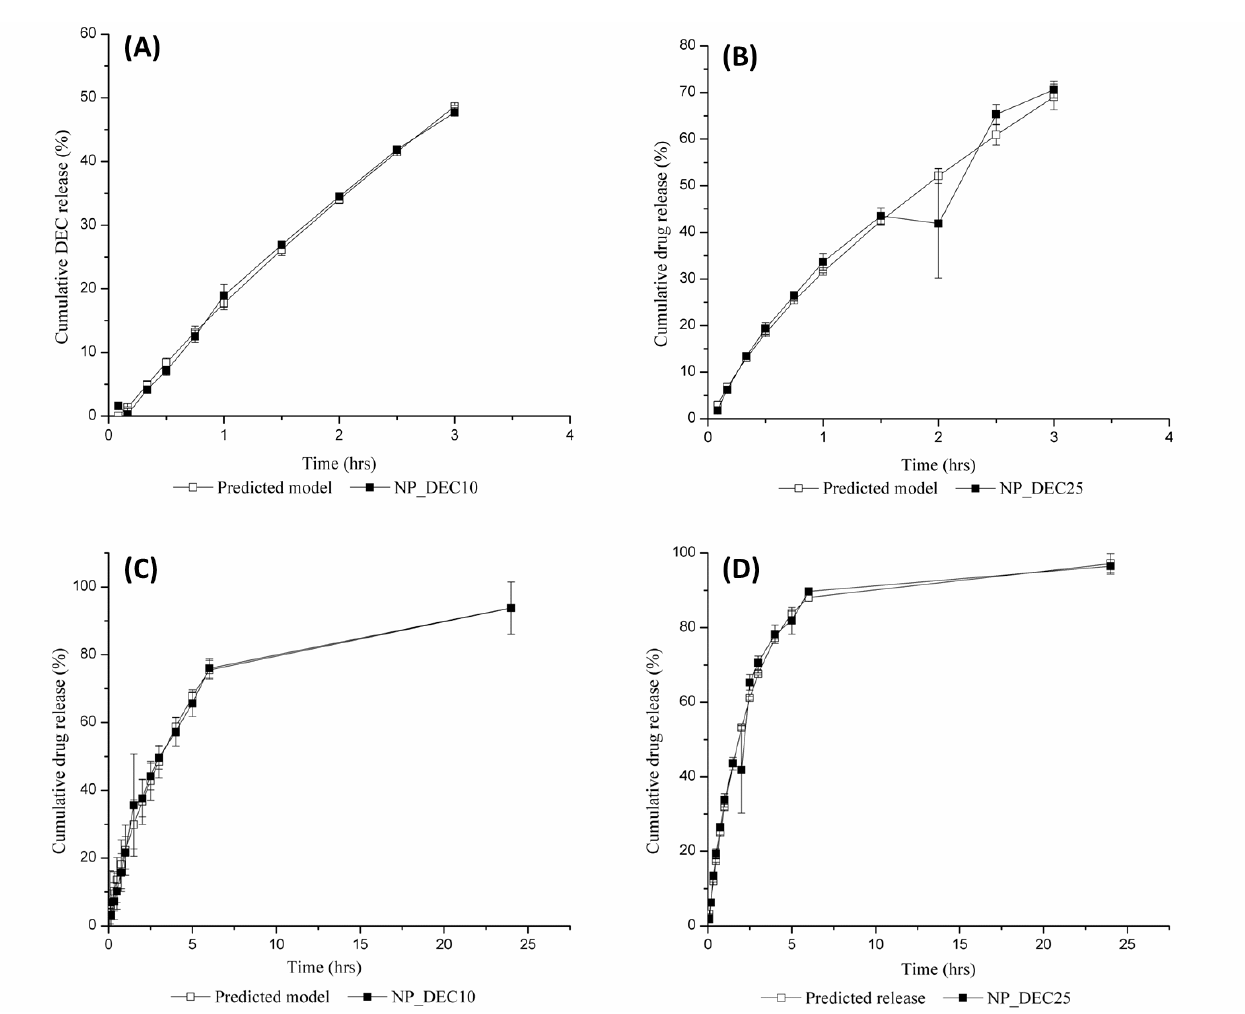
FIGURE 2 - In vitro drug release profile of (A) NP_DEC10 and (B) NP_DEC25 for 3 hours, and (C) NP_DEC10 and (D) NP_DEC25 for 24